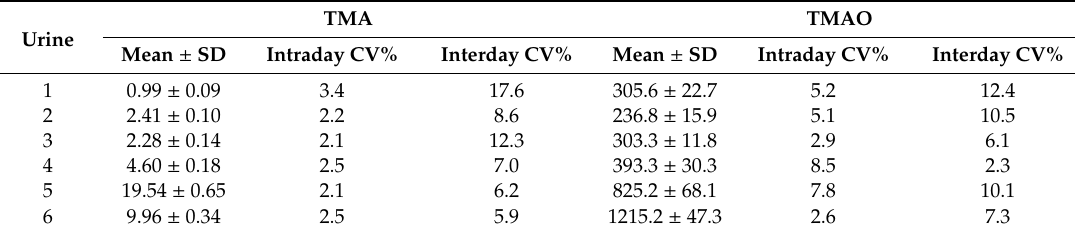
Table 2. Precision of the TMA and the TMAO concentrations (in µ M) measured in 6 urine samples with di ff erent levels over a span of more than 10 days.